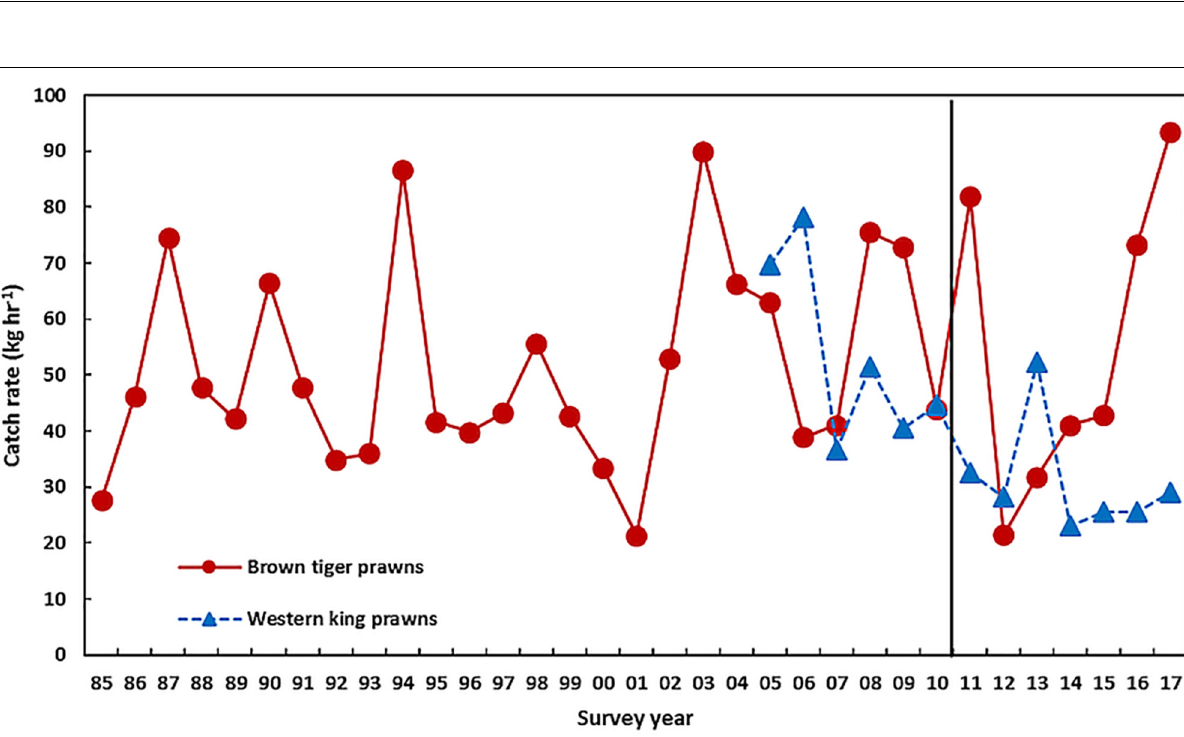
Frontiers in Marine Science |